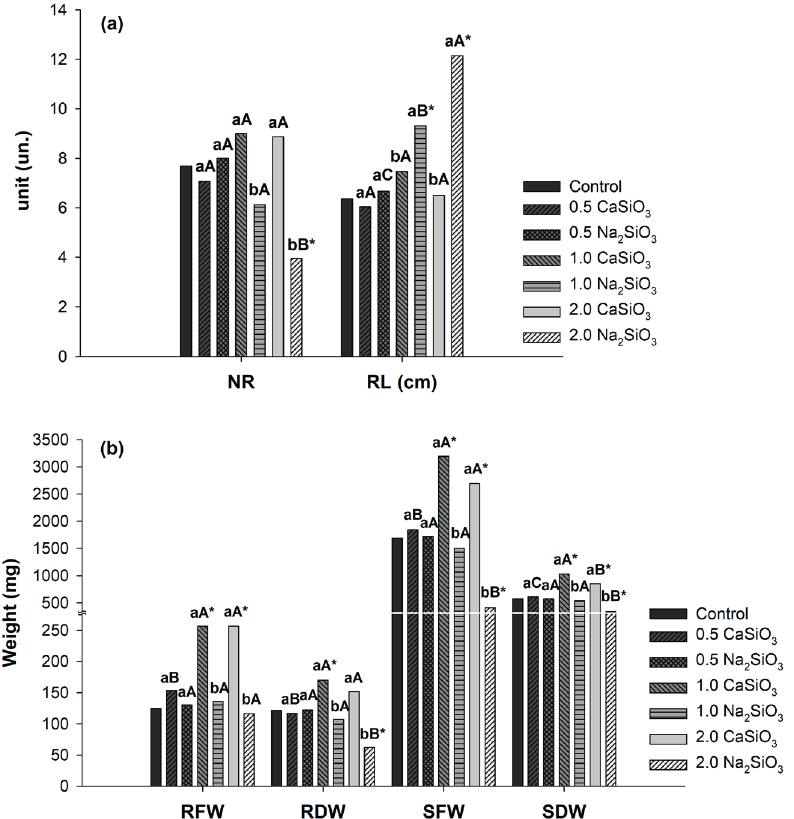
Figure 5 - Growth analysis in plants of B. zebrina as a function of different sources and concentrations (mg L -1 ) of silicates after 60 days of ex vitro growth. (a) Number of roots (NR), root length (RL) in cm; (b) Root fresh weight (RFW), root dry weight (RDW), shoot fresh weight (SFW) and shoot dry weight (SDW) in mg. Means followed by ‘*’ are different from the control by Dunnet’s multiple range test at 5% probability; lowercase letters refer to the unfolding of the sources within each concentration. The means with distinct lowercase letters are different by Tukey’s multiple range test at 5% probability; capital letters refer to the unfolding of concentrations within each source, the means with distinct capital letters are different by Tukey’s multiple range test at 5%